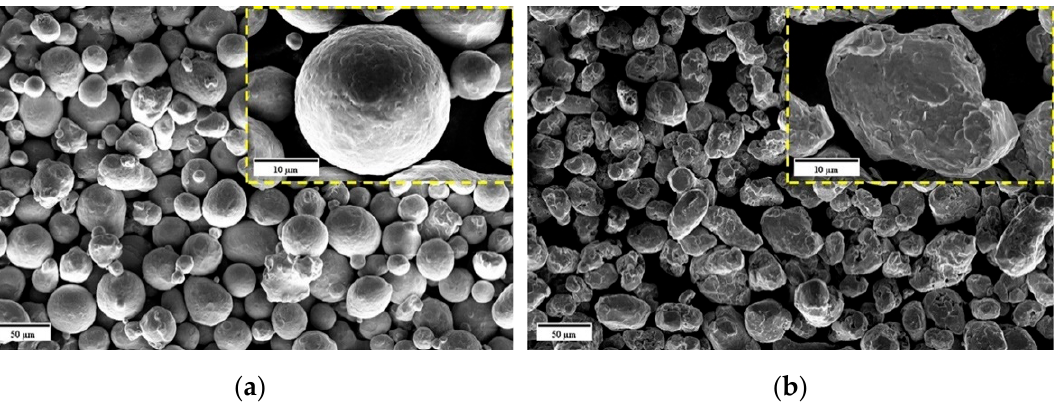
Figure 3. Morphology of 4130 steel powders obtained using the two systems: ( a ) gas-atomized and ( b ) water-atomized (reproduced with permission from [43]; Copyright © 2021 Elsevier).